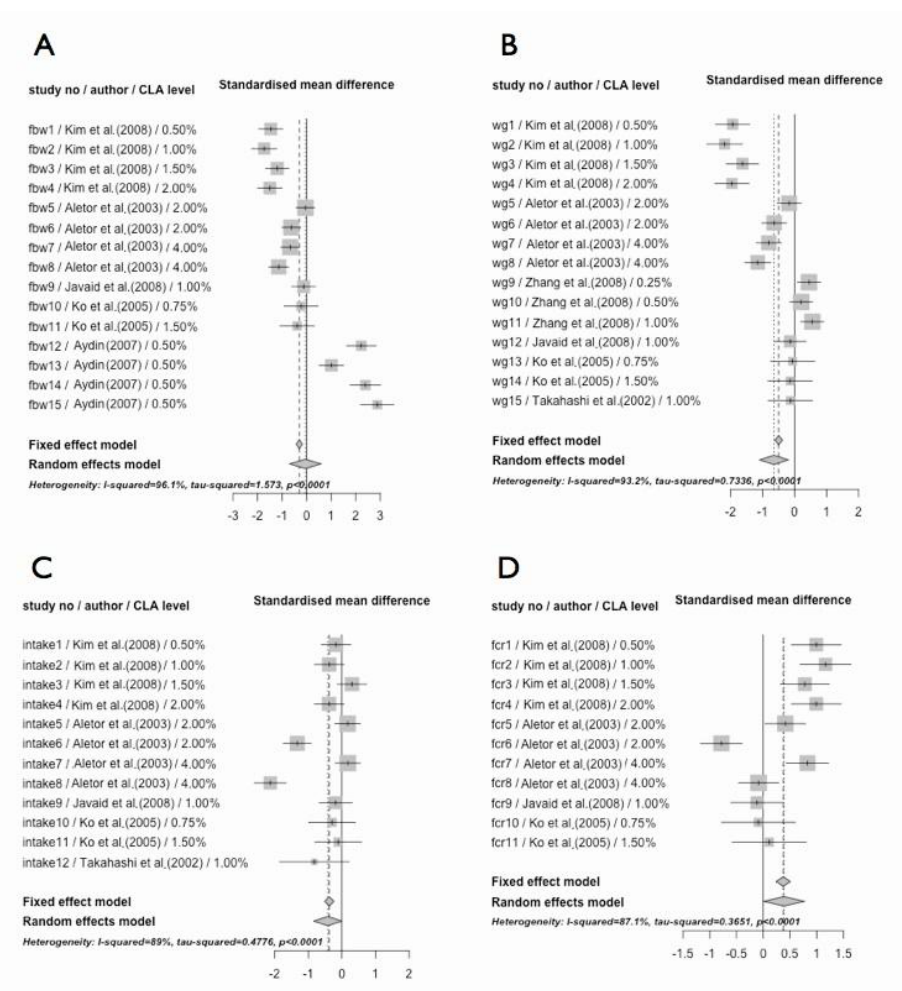
Figure 1. Forest plots for the effect of CLA feeding on growth performance of